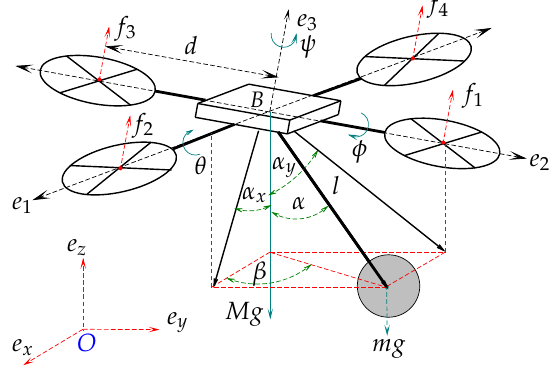
Figure 1. Three-dimensional quadrotor with a cable-suspended